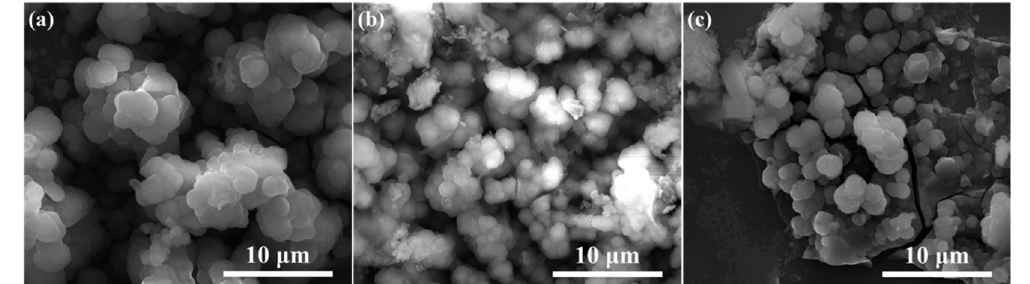
Figure 10. The SEM images of 304 stainless-steel samples after being treated by polarization measurement in different solutions and a 4 week immersion test in SG + Na 2 SeO 4 solution: ( a ) SG + CaCl 2 solution; ( b ) SG + Na 2 CO 3 solution; ( c ) SG + Na 2 SiO 3 solution.